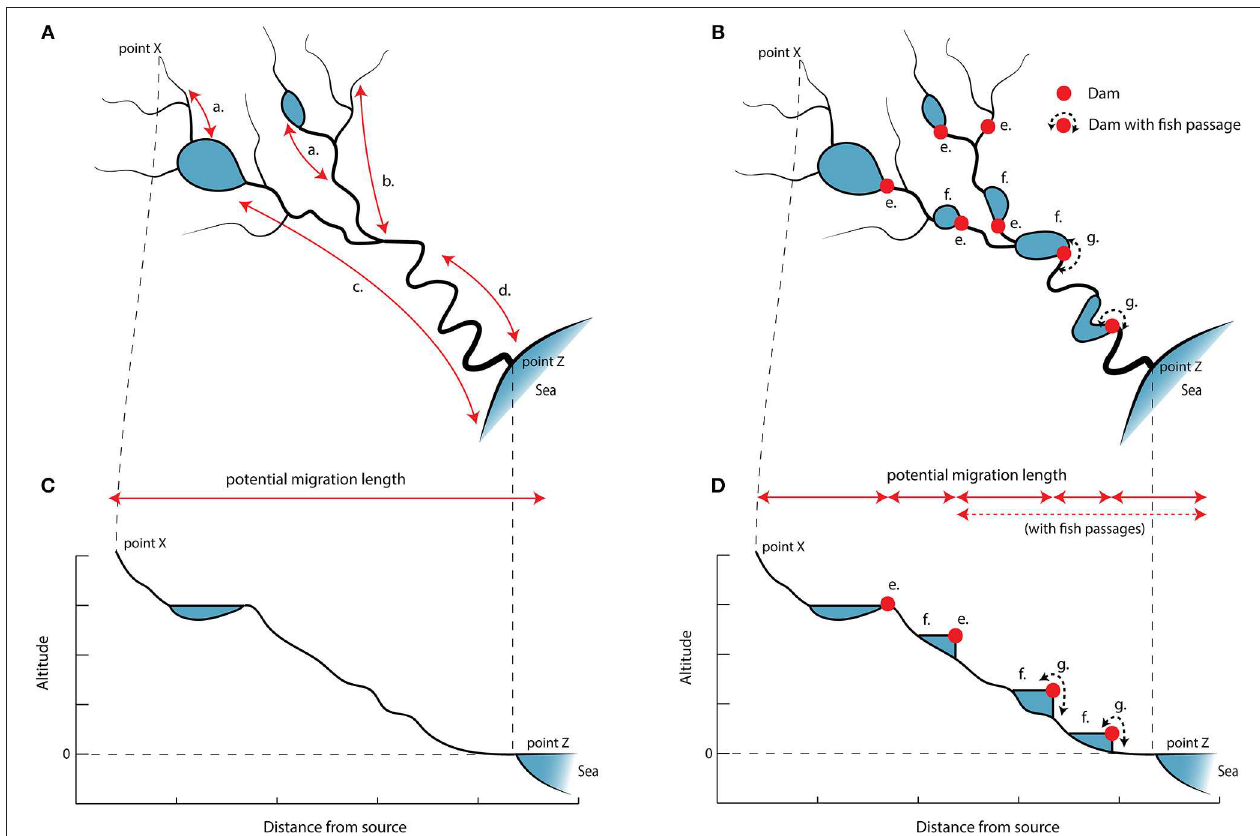
FIGURE 4 | Variation in fish migration and consequences of exploitation and management actions. (A) A river system showing the principal modes of migration for fish inhabiting the system. Fish migrate (a) between lakes and rivers, (b) between larger and smaller parts of the river, (c) between sea and lakes, and (d) between the sea and river. (B) When dams (e) are added to a river system, previous migration routes become disconnected and the total amount of freely available habitat fragments becomes smaller. Damming structures create impoundments (f) that store water, converting lotic habitats to lentic habitats. Connectivity can be partially restored by adding fish passages (g) that enable fish to pass obstacles, but the impoundments created upstream of damming structures persist even though fish passages are built. The height profiles (C,D) drawn from point X to point Z illustrate how damming changes the large-scale structure of a river system to a series of steps. The potential migration length for freshwater fish in the river system is severely shortened, limiting access to areas that may provide better opportunities for growth, survival, or reproduction for